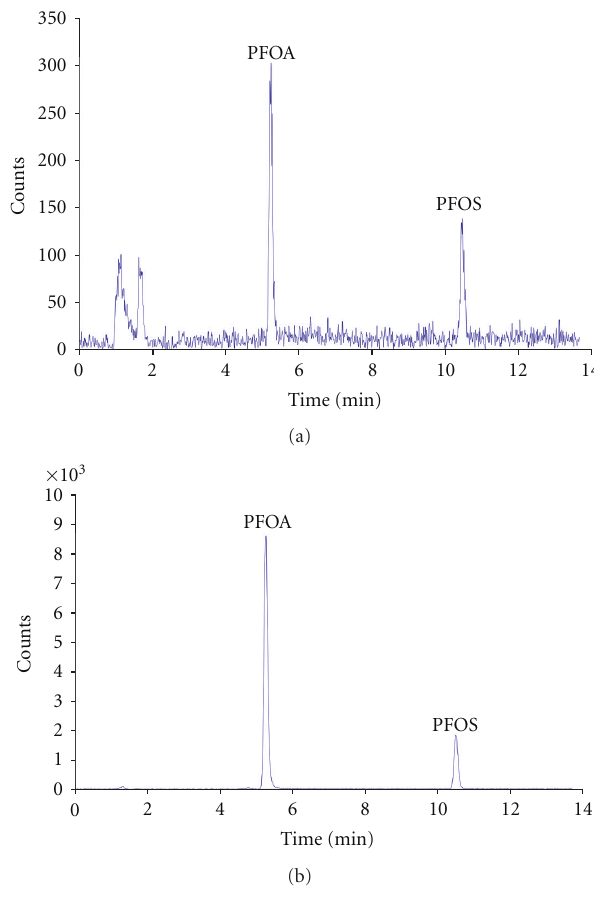
Figure 1: MRM total ion chromatogram for (a) extracted fish sample and (b) standard